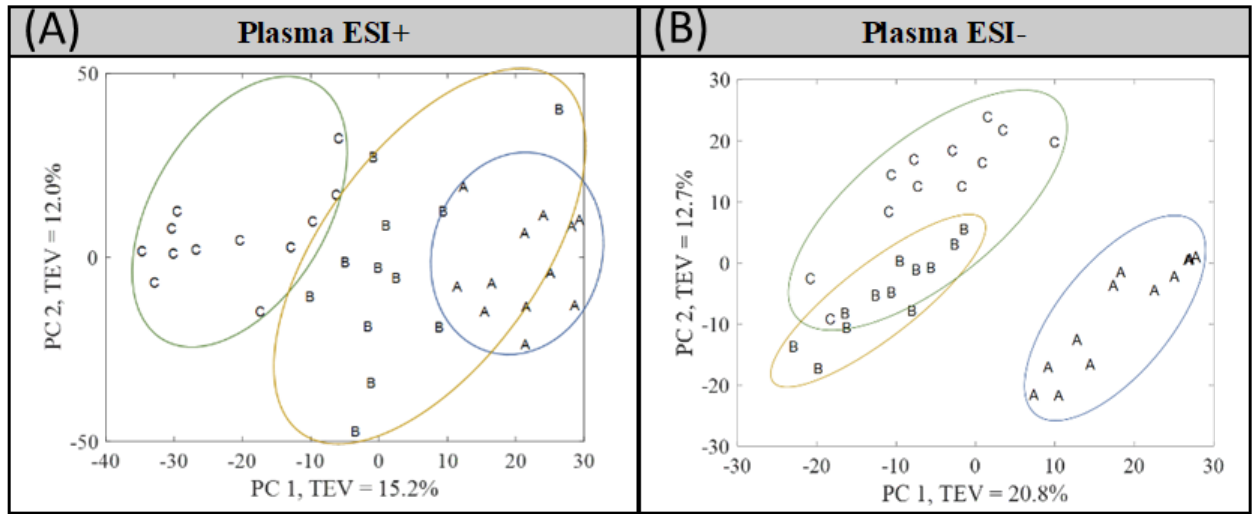
Figure 1. PCA score plots obtained after QC samples were removed for the matrices of ( A ) Plasma ESI+ and ( B ) Plasma ESI − . Piglet groups: newborns (A), infants (B), and children (C). TEV = total explained variance.